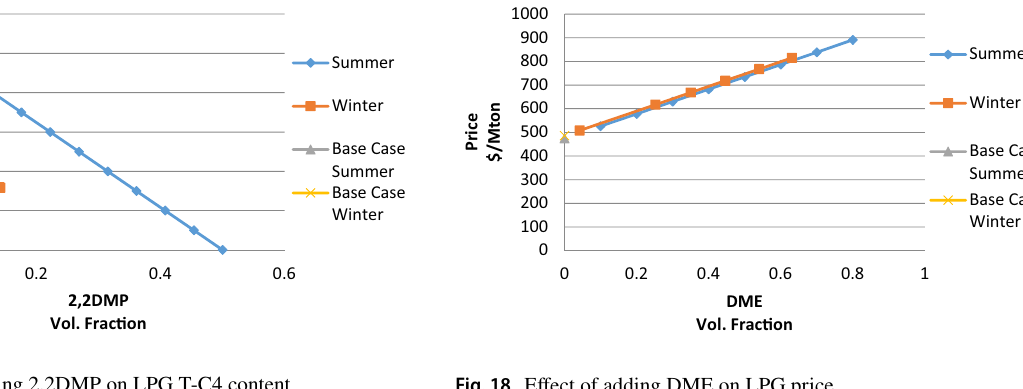
Fig. 18 Effect of adding DME on LPG price